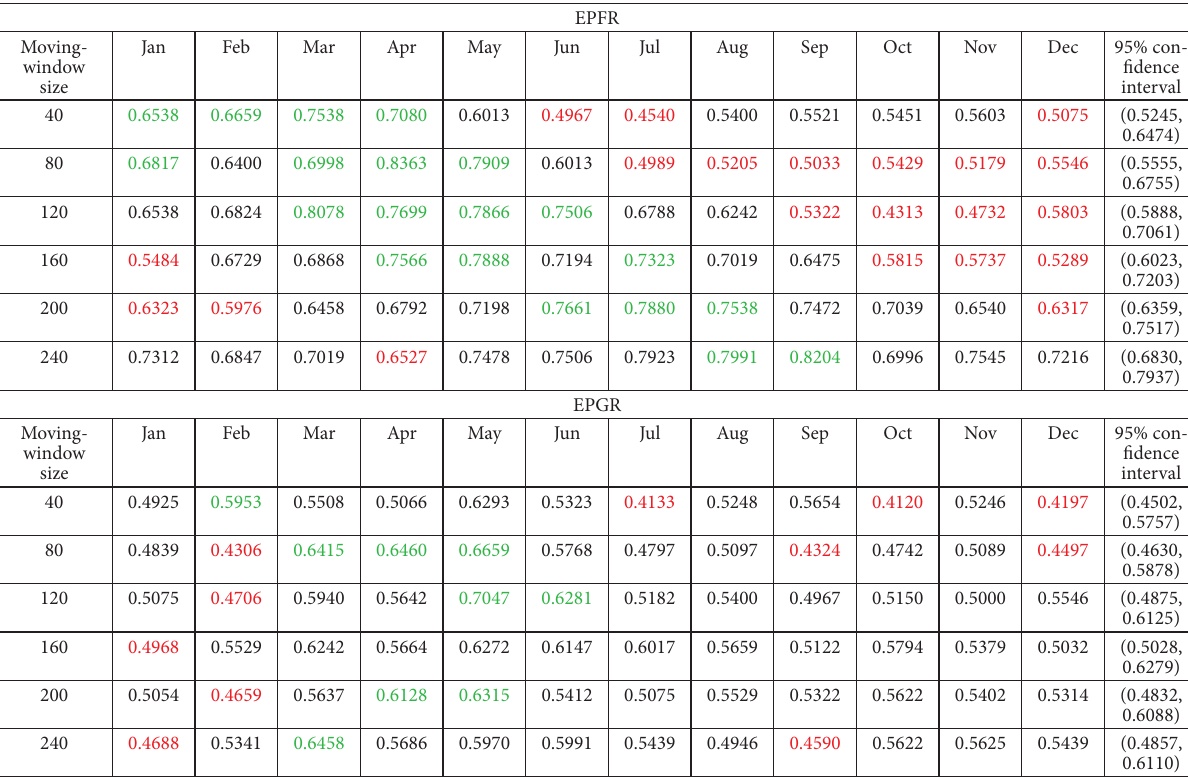
Table 7. The test results for the overall calendar effect using Method